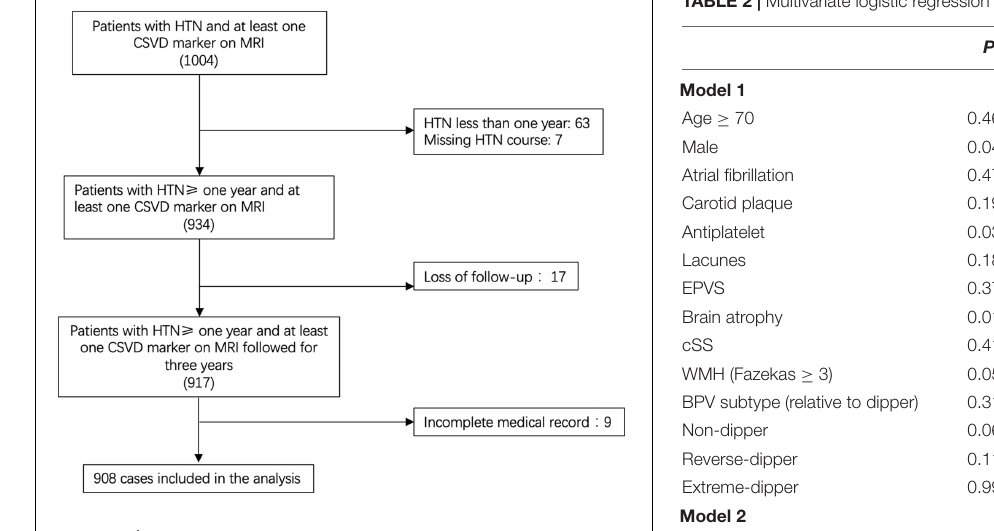
FIGURE 1 | Flowchart of patient inclusion. CSVD, cerebral small vascular disease; HTN, hypertension.